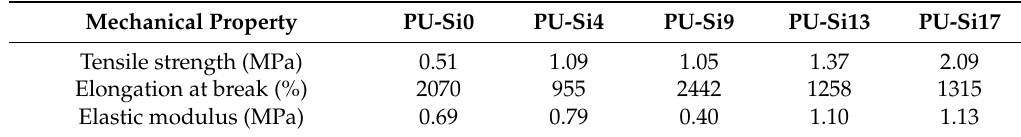
Table 3. The mechanical properties of five coatings.